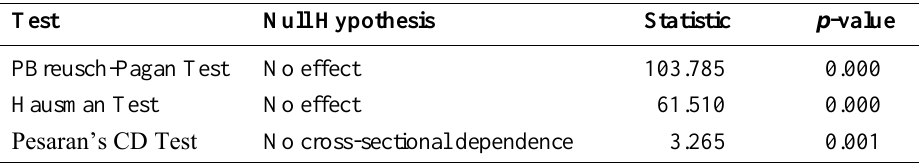
Table 4: Preliminary Diagnostic